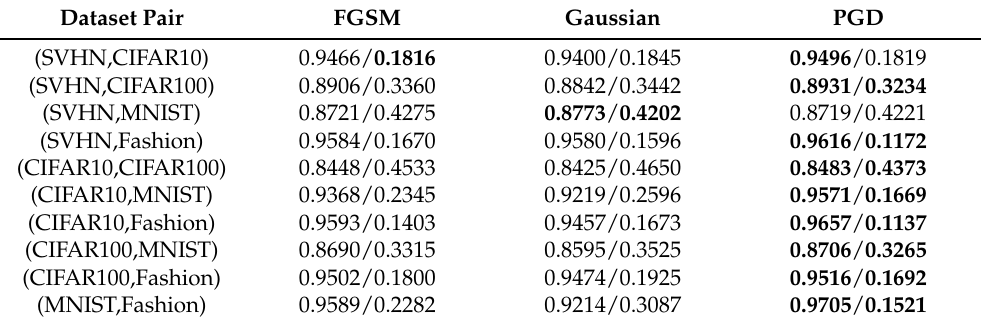
Comparison of the OOD detection performance of AdvSCOD measured by AUROC avg /FPR95 avg with different types of perturbation. Bold numbers are superior